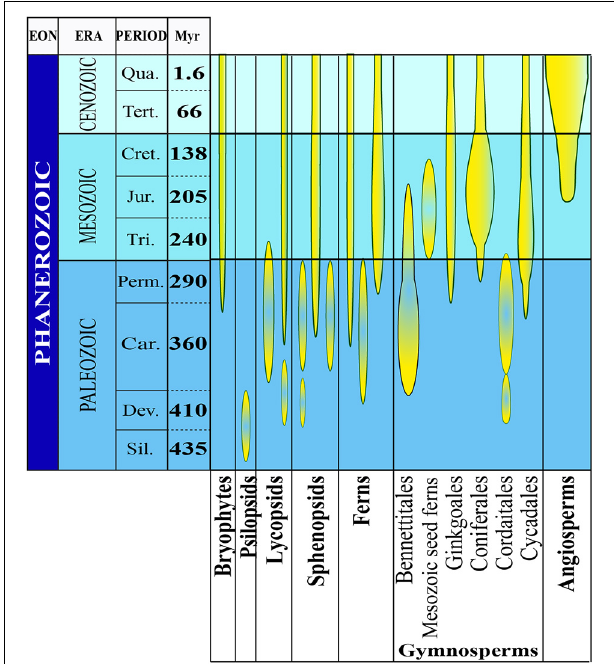
FIGURE 1 | The evolutionary history of plants. The abundance and diversity of plant fossils increase in the Silurian Period where the first macroscopic evidence for land plants has been found. There is evidence for the evolution of several plant groups of the late Devonian and early Carboniferous periods (homosporous ferns and gymnosperms). From the late Devonian through the base of the late Cretaceous period, gymnosperms underwent dramatic evolutionary radiations and became the dominant group of vascular plants in most habitats. Flowering plants probably also originated during this time, but they did not become a significant part of the fossil flora until the middle of the Cretaceous Period (Modified from Occhipinti et al., 2014).